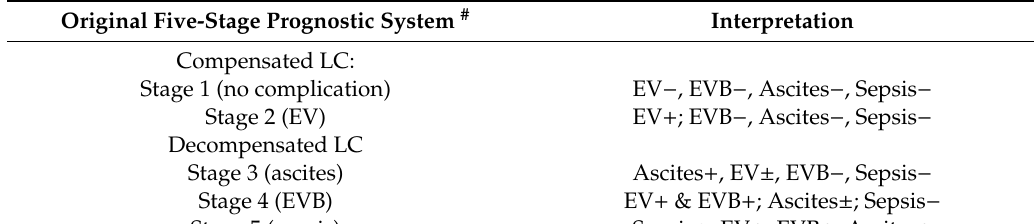
Table 1. The original five-stage and proposed seven-stage